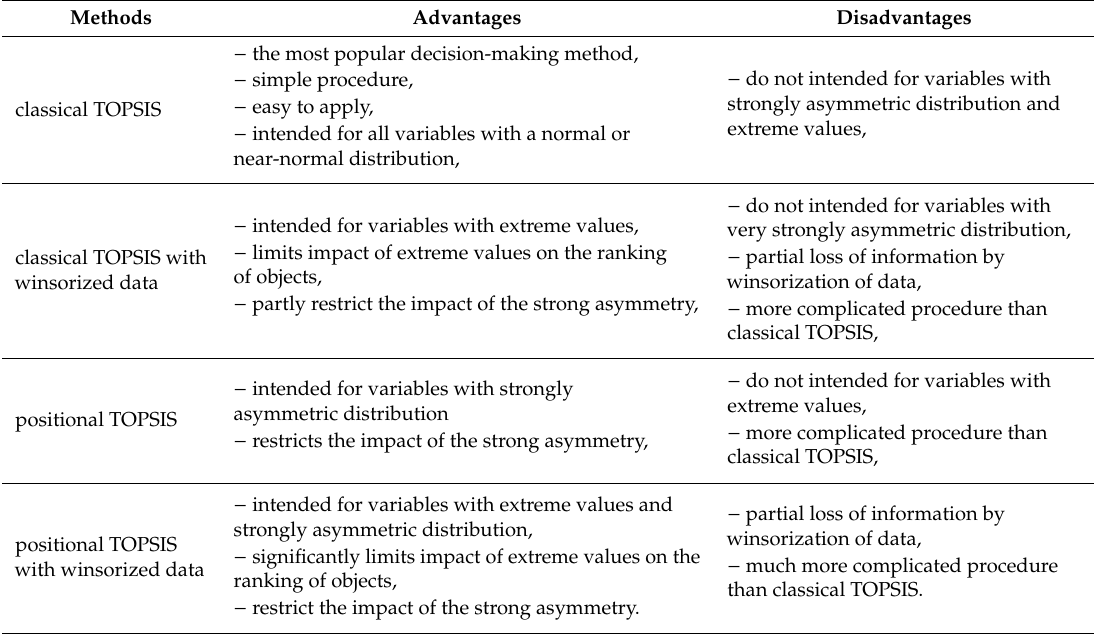
Table 9. Advantages and disadvantages of di ff erent variants of